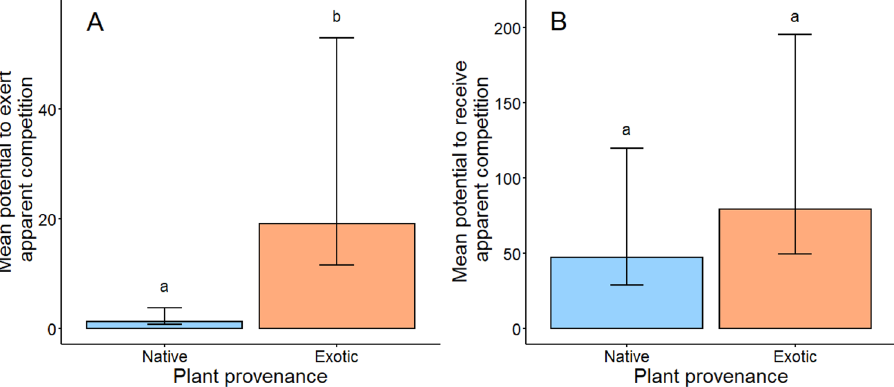
Fig. 4 Potential for apparent competition (PAC) of native and exotic plants. A Exotic plant species (orange, n = 320) generated 14 times higher PAC exerted compared with native plant species (blue, n = 320; F 1,40 = 7.07, P = 0.011). B PAC received did not signi fi cantly differ between native and exotic plants ( n = 320 per plant provenance; F 1,38 = 0.07, P = 0.575). Different lowercase letters indicate signi fi cant differences ( P < 0.05) between back- transformed estimated marginal means (±SEM) from linear mixed models. Corresponding violin plots showing the distribution of raw data are presented in Supplementary Fig.